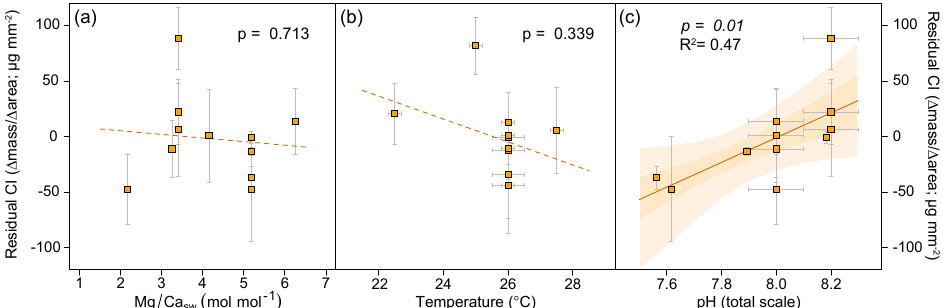
Figure 3. Ambient environmental response of chamber-addition corrected residual CI (change in mass/change in area compared to the logarithmic regression through all experiments shown in Fig. 2; see text for justification). (a) Mg / Ca sw , (b) temperature, (c) pH. Shaded regions are 1 σ and 2 σ bounds of uncertainty, as calculated via combined wild bootstrap and Monte Carlo analysis, accounting for error in X and Y variables, following Henehan et al. (2016). Dashed lines indicate non-significant relationships, solid regression lines are significant to α < 0 . 05. Shaded regions of uncertainty are 1 and 2SD of 1000 Monte Carlo linear regression models through randomly simulated datasets sampled within the given 2 σ X - and Y -error margins for each sample. Mg / Ca sw analytical uncertainty is ± 3% (Evans et al., 2015), smaller than symbol size in (a)